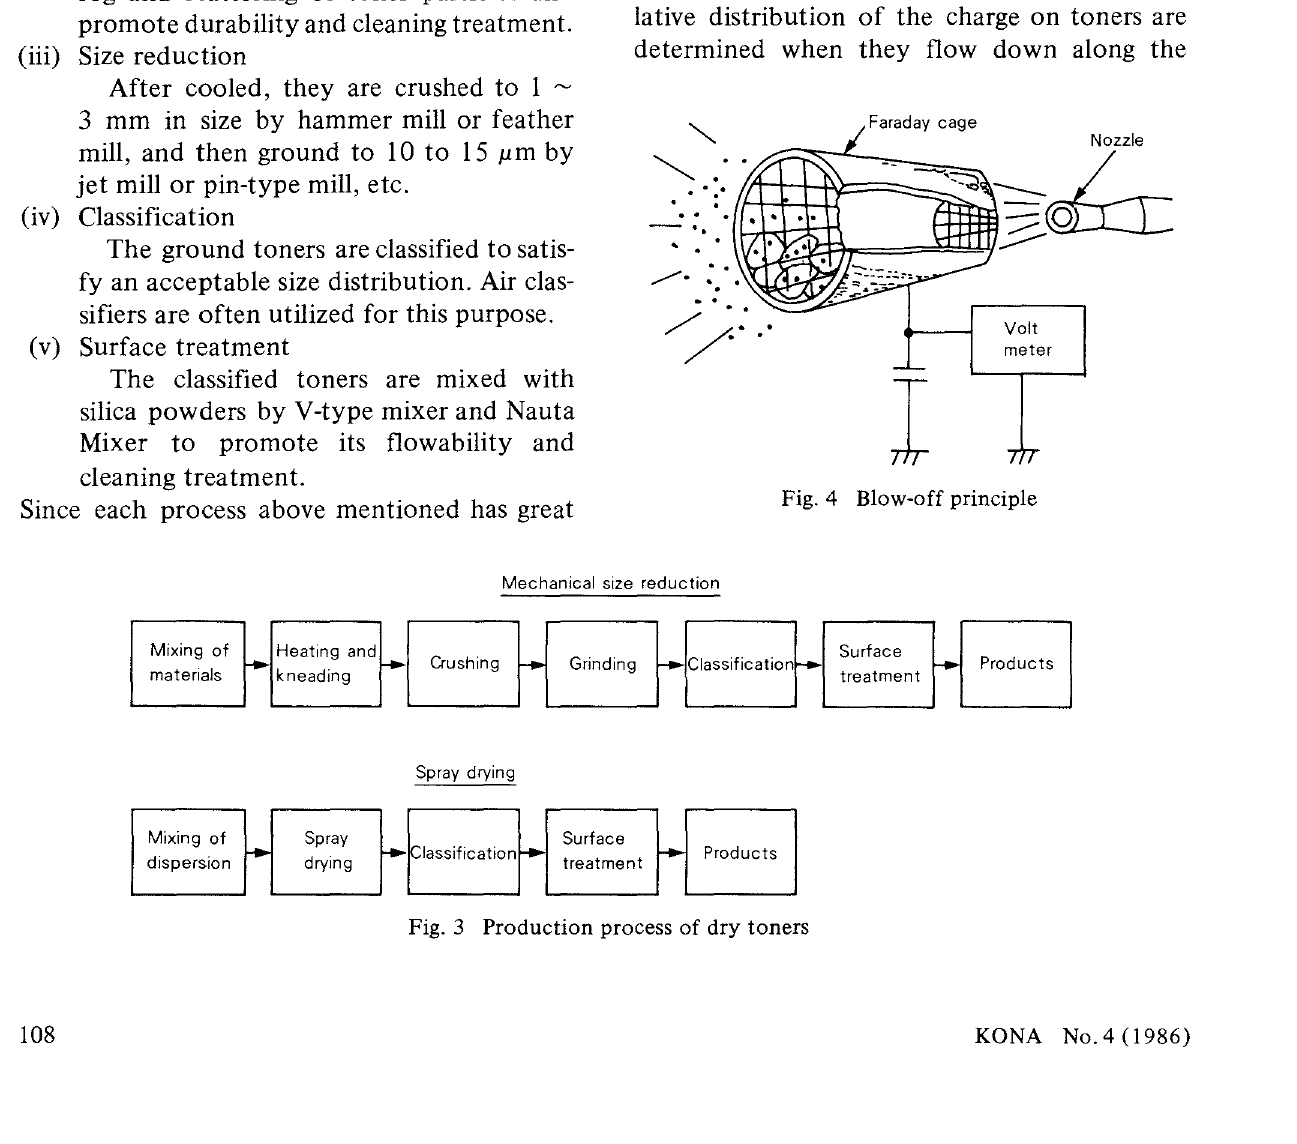
Fig. 4 Blow-off principle